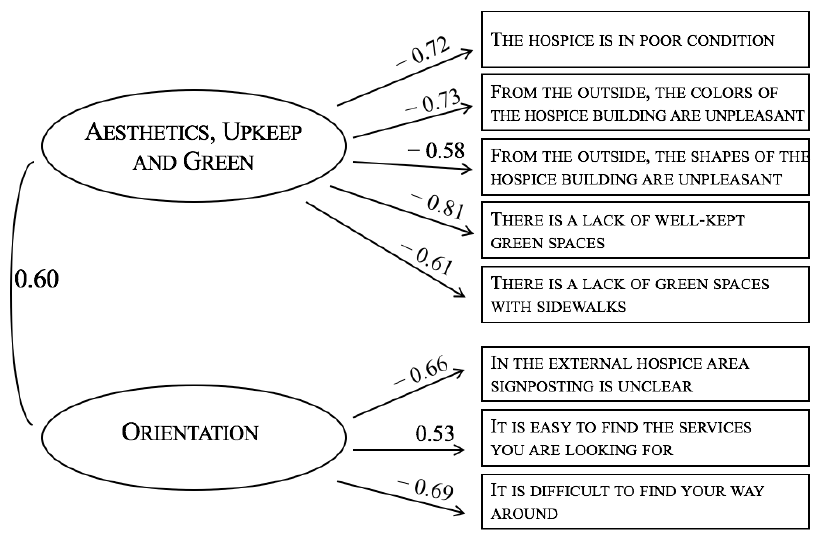
Figure 2. CFA. External Spaces. Correlation between F1 and F2 is r = 0.60 ( p <